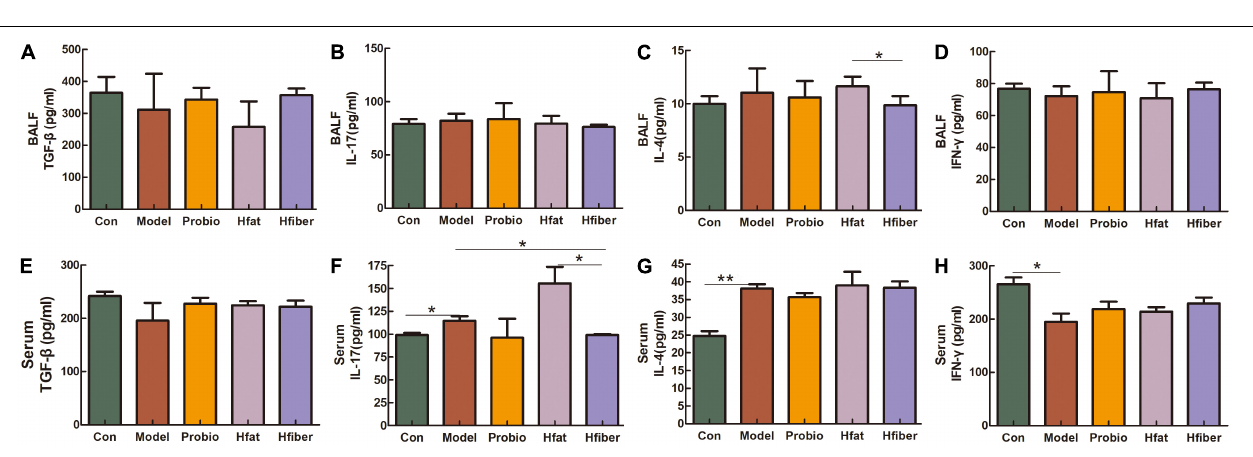
FIGURE 3 | Histology of H&E-stained lung tissue (original magnification: × 100). Photomicrographs were captured to detect eosinophil infiltration. Eosinophil infiltration was significantly higher in the Hfat group than the other groups. Interestingly, eosinophil inflammation was suppressed dramatically consumption of a high-fiber diet. n = 5-8 rat/group.